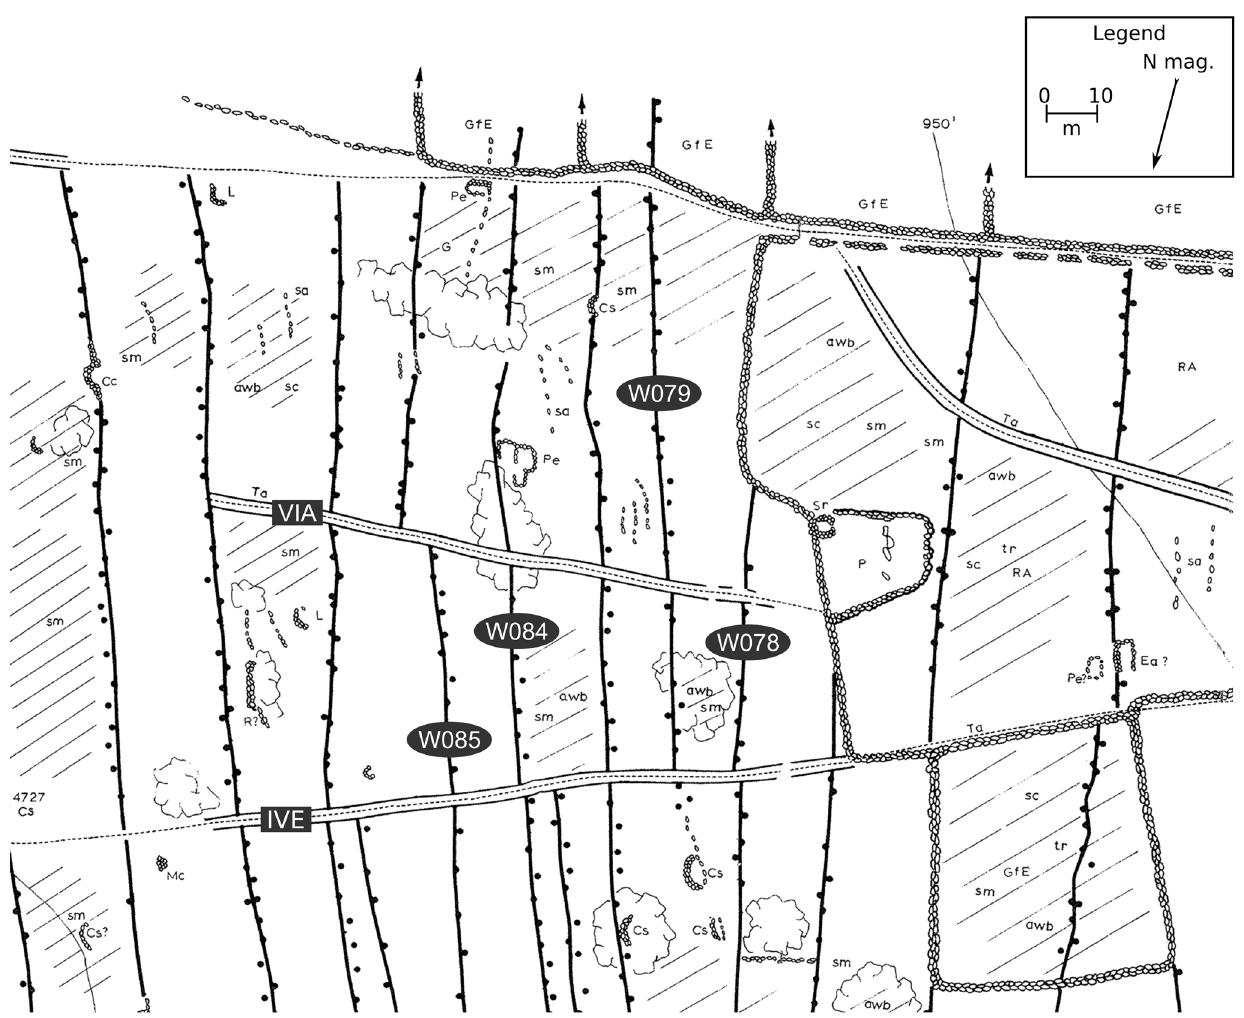
Figure 7. Cycles in a portion of the map of the Lapakahi detailed study area. See the text for an explanation of the map. The full map of the Lapakahi detailed study area is included as Figure S1, which includes a legend.